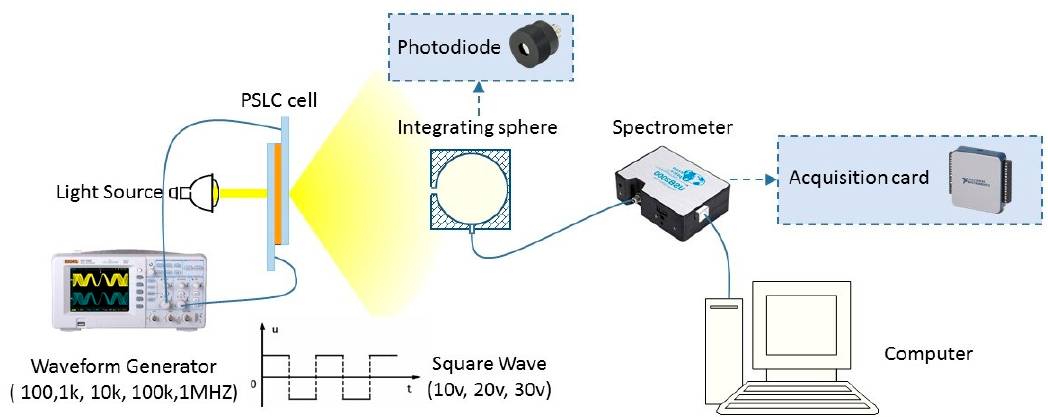
Figure 4. Experiment setup for transmittance and response time measurement (when measuring response time, the integrating sphere was replaced with a photodiode, while the spectrometer was replaced by amplifier and acquisition card). 149